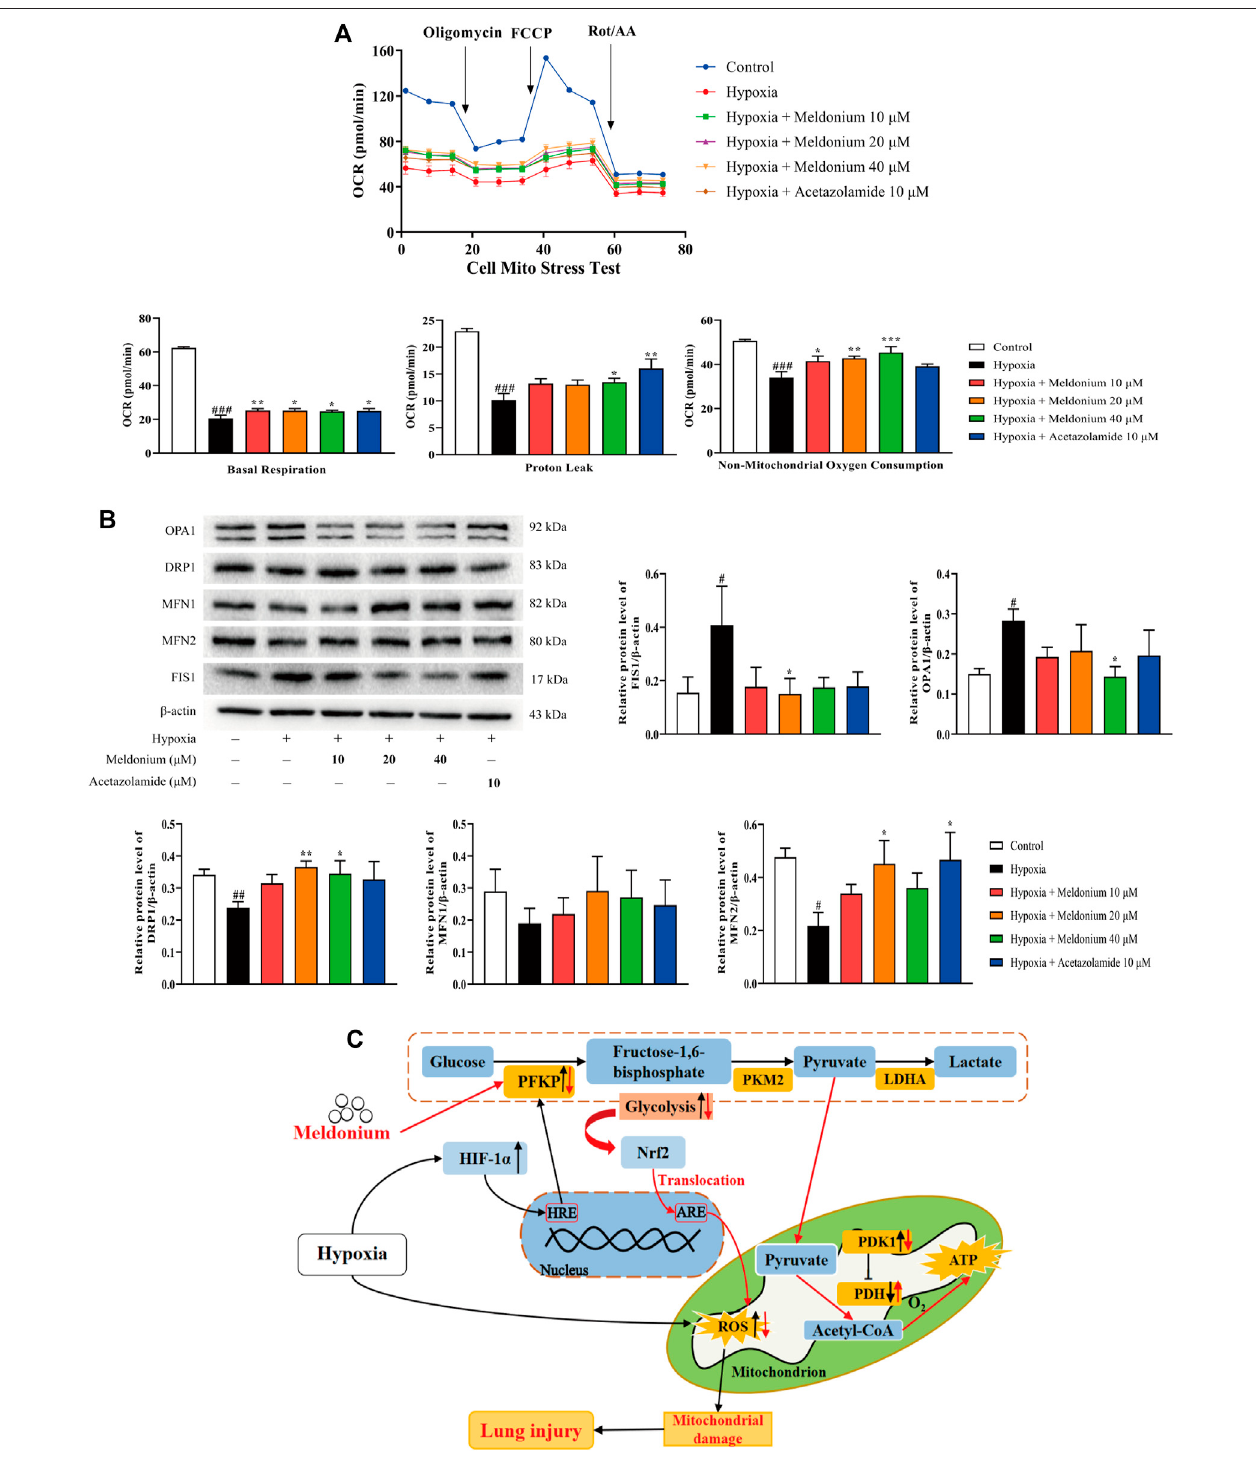
FIGURE5| Amechanisticillustrationofmeldonium ameliorationofoxidativestress – inducedmitochondrialdamage. (A) Oxygenconsumptionrate(OCR) diagram, basal respiration, proton leak, and non-mitochondrial oxygen consumption in vitro after hypoxia for 24 h were detected using the Cell Mito Stress Test Kit (n > 3). (B) Protein expression of mitochondrial fi ssion and fusion in vitro after hypoxia for 24 h were detected via western blot ( n = 3 – 5). (C) A schematic diagram depicting a potential mechanism by which meldonium regulates glycolysis to alleviate hypoxia-induced lung injury. Mechanistically, meldonium can regulate and interact with PFKP to regulate glycolysis that is one of main energy metabolic pathway, while promoting Nrf2 transfer from the cytoplasm to the nucleus. Substantially, Nrf2 actives